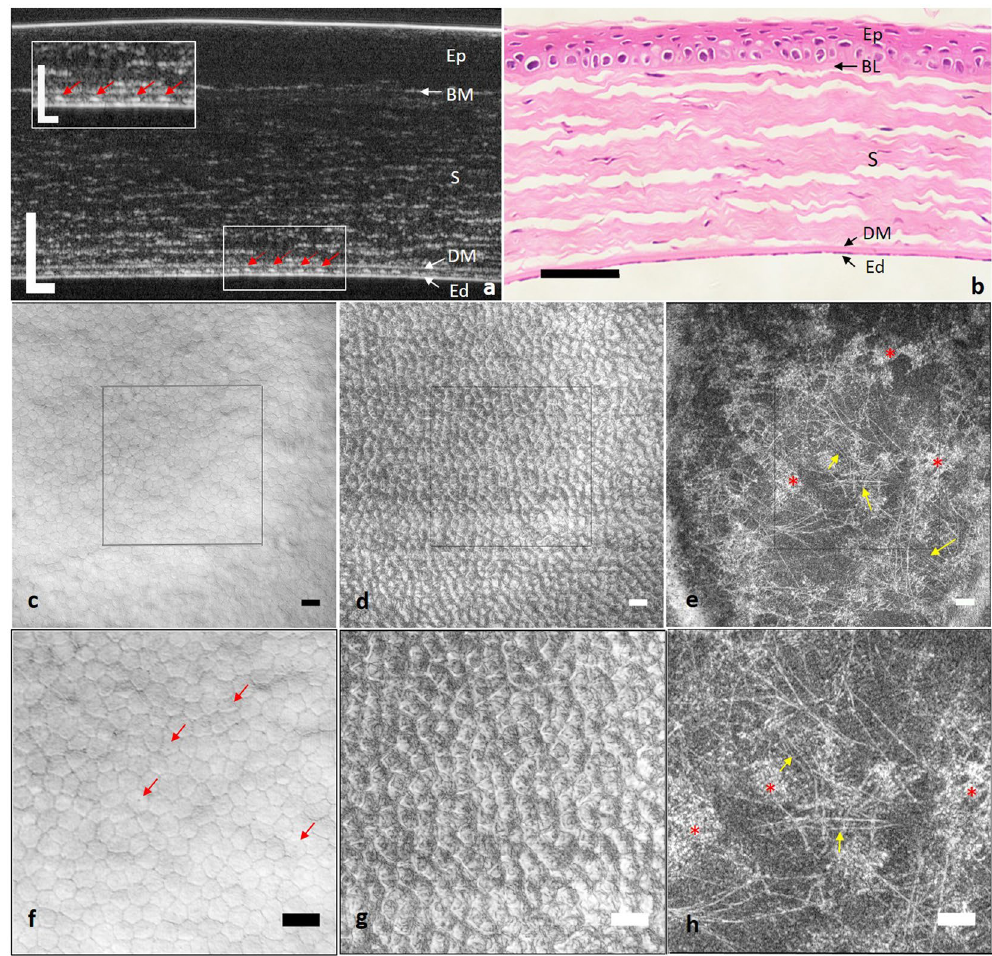
Figure 2. Ex vivo µ OCT imaging of rat cornea. ( a ) Cross-sectional µ OCT image of rat cornea. Inset is the zoomed-in view of the rectangular area; red arrows indicate endothelial cells. ( b ) Cross-sectional histological image of rat cornea. ( c ) En face view of the apical side of the endothelium demonstrated regularly arranged polygonal cells with low reflective cell boundaries. ( d ) En face view of the interface between the endothelium and DM, which corresponded to the basolateral side of the endothelium, presented a highly scattering lattice. ( e ) En face view of posterior stroma. Stellate keratocytes (red asterisks) and linear collagen fibres (yellow arrows) were both visualized. ( f – h ) Zoomed-in view of the square region in ( c – e ). Dark spots are probably cilia of endothelial cells (red arrow in f ). Ep: epithelium; BL: Bowman’s layer; S: stroma; DM: Descemet’s membrane; Ed: endothelium (Scale bar = 50 µ m and scale bar of inset in ( a ) represents 25 µ